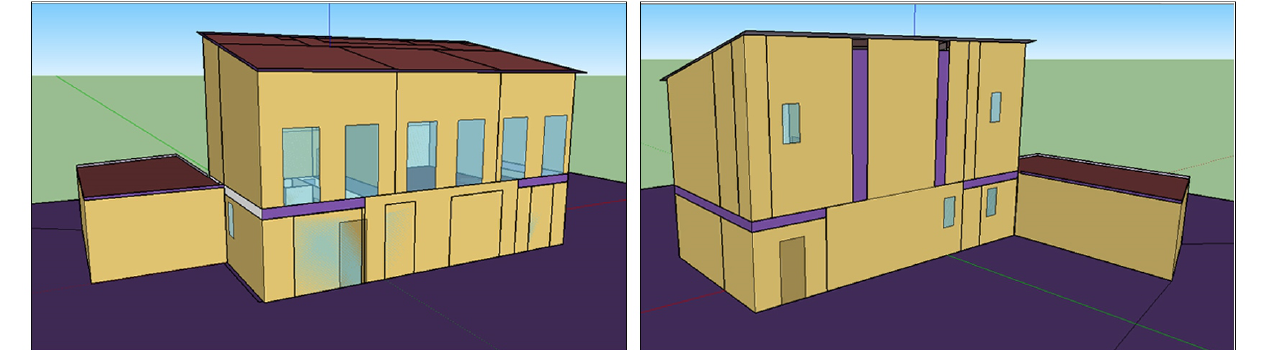
Figure 7. Residential gbXML file imported in Open